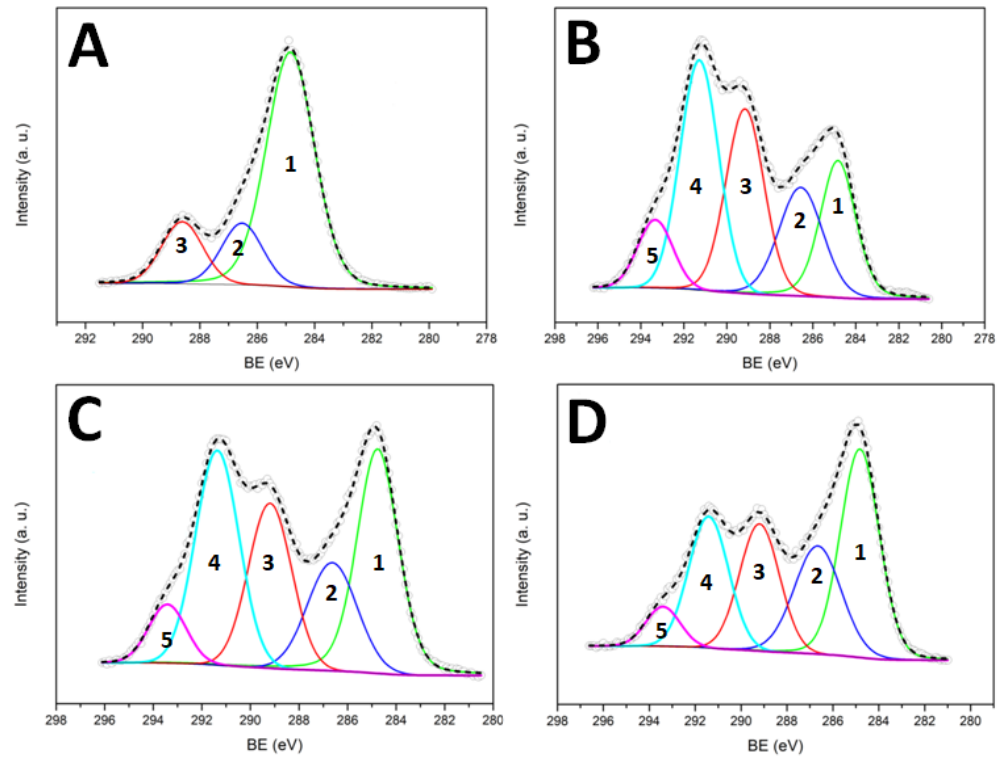
Figure 4. C1s peak deconvolution for untreated PMMA ( A ), PMMA treated one time ( B ), PMMA treated five times ( C ) and PMMA treated one time and stored in air for 15 days ( D ). The five